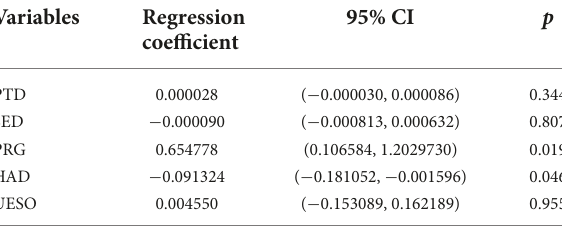
TABLE 3 The logistic regression analysis between different measures and